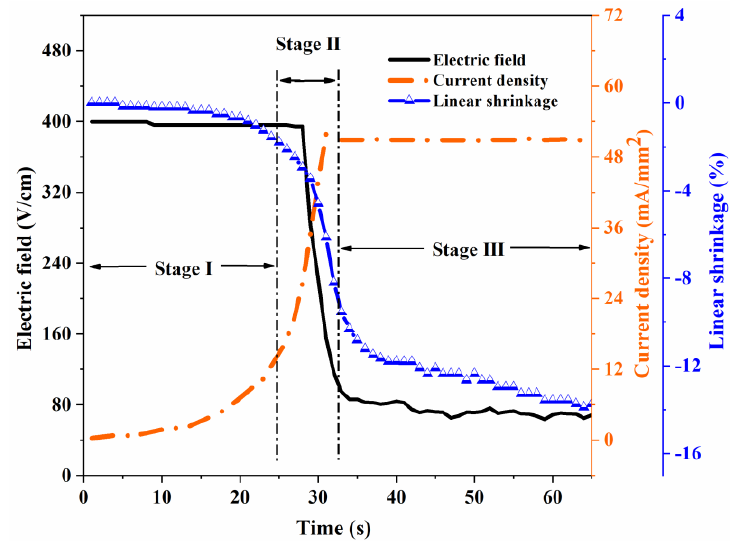
Figure 1. Electric field, current density and linear shrinkage as a function of time during flash sintering.